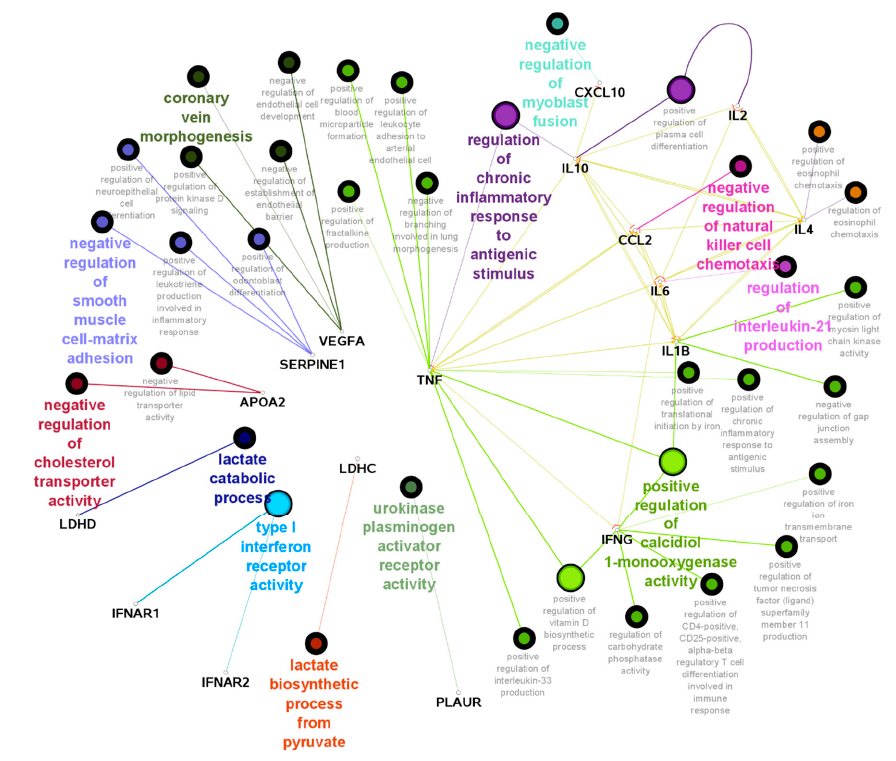
Figure 2. Enriched pathway analysis associated with COVID-19 aggressive-related genes.